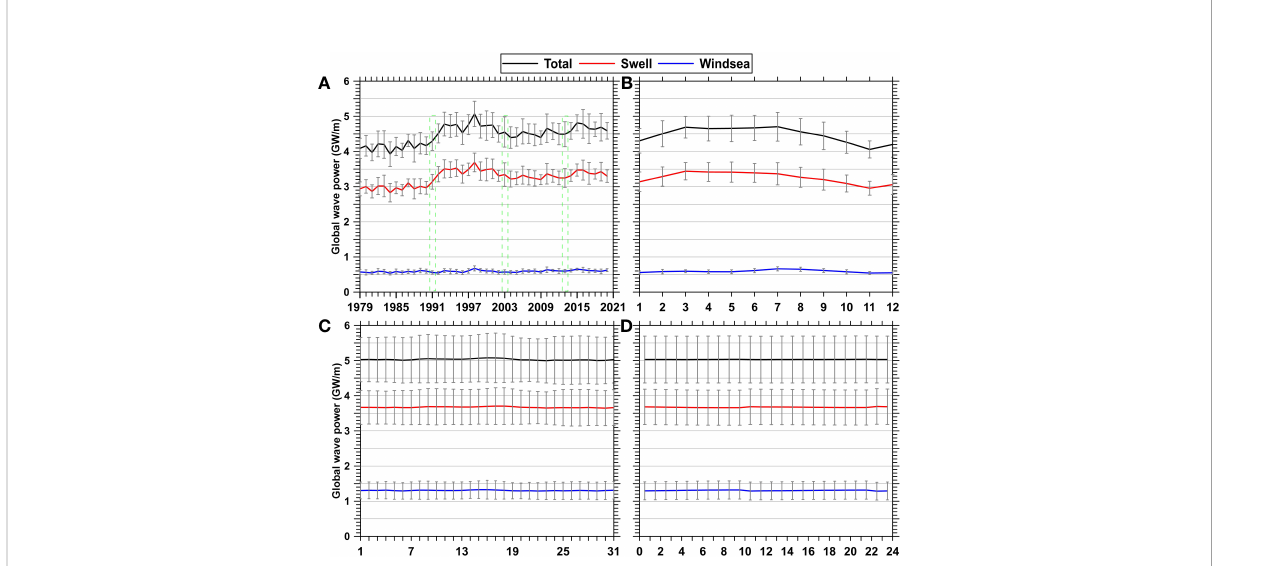
FIGURE 3 Temporal changes in the averaged wave power calculated globally from 1979 to 2020. (A) Yearly and (B) monthly global wave power based on the monthly product, and (C) daily and (D) hourly global wave power based on the hourly product. The error bars represent the standard